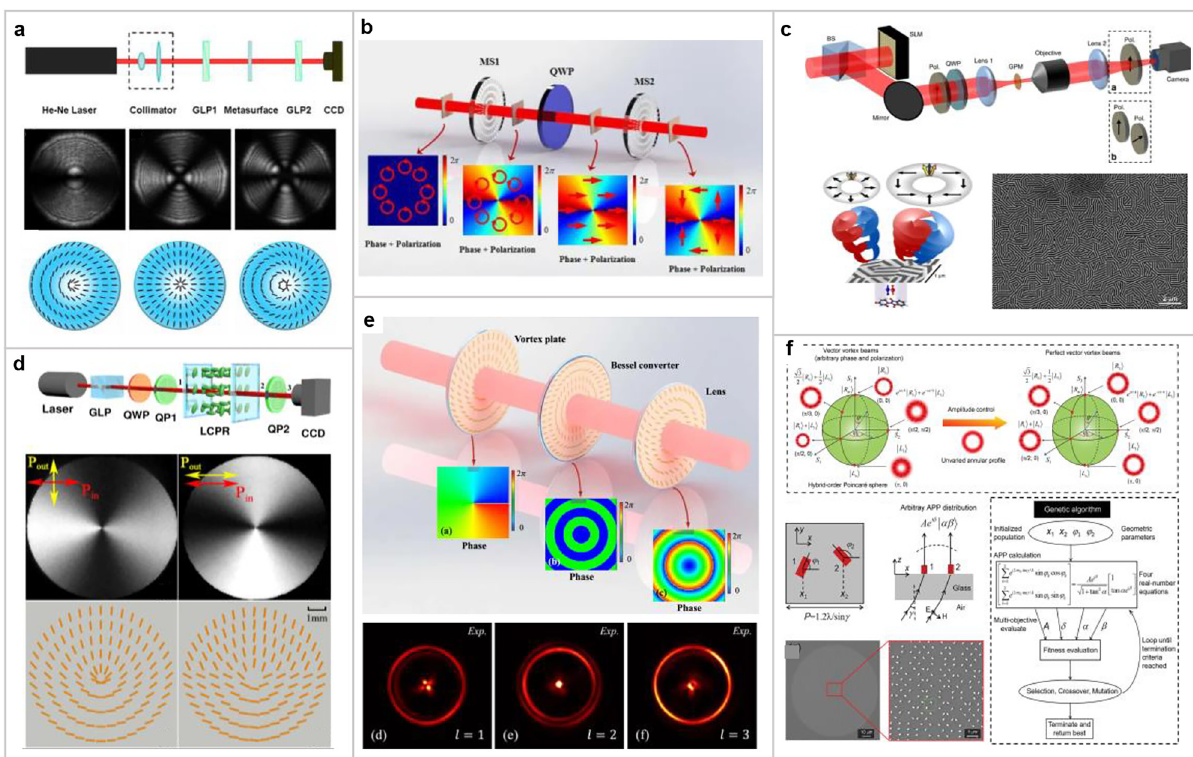
Figure10: Applicationsof vectorvortexbeamgenerators with all-dielectric metasurfaces.(a)The patternof threetypesof outputvectorbeam through the polarizers (up), the corresponding dielectric metasurfaces with polarization order q = 0.5, 1.0, 1.5, respectively (down). The black lines represent the slow axis spatial distribution of the metasurfaces [137]. (b) The schematic of the vector vortex beam generation, in which MSmeans metasurface andQWP meansquarter-waveplate [138]. (c) Schematicof vectorialvortex beamswith windingnumbers l = 1 and l =